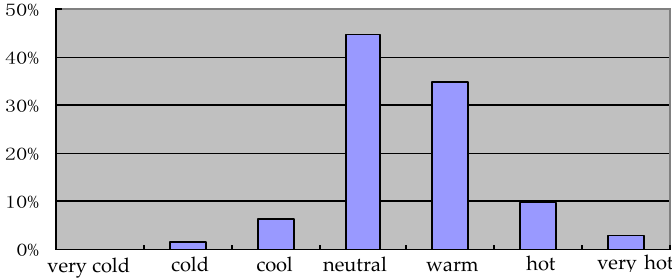
Figure 1. Indoor objective thermal index evaluated score results.